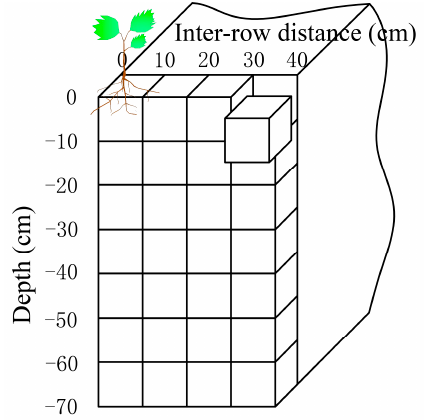
Figure 4. Schematic representation of the soil core method.